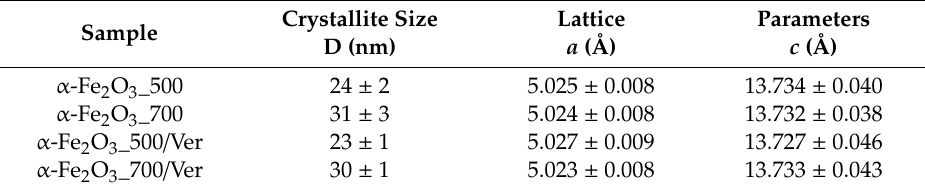
Table 1. α -Fe 2 O 3 nanoparticles: the mean coherent crystallite size and lattice parameters.